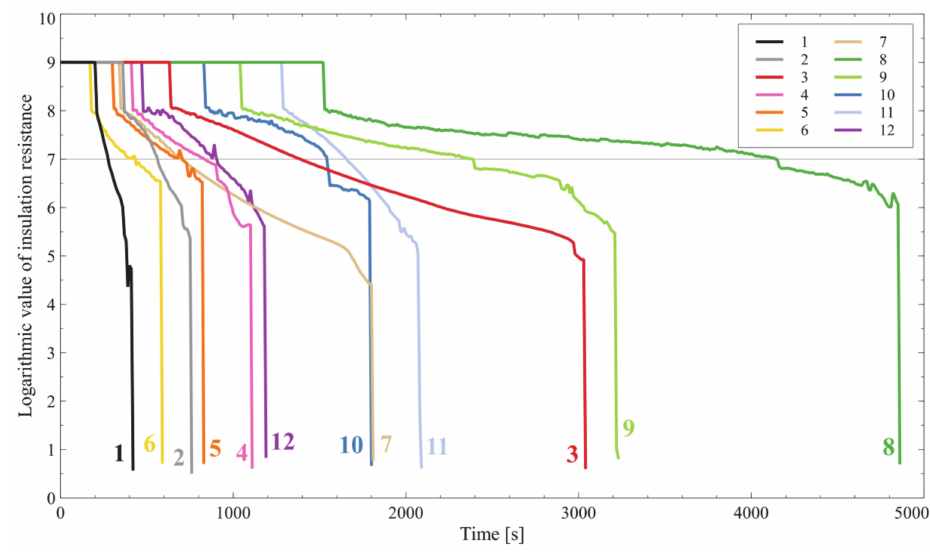
Figure 10. Insulation resistance change curves for 12 cases.